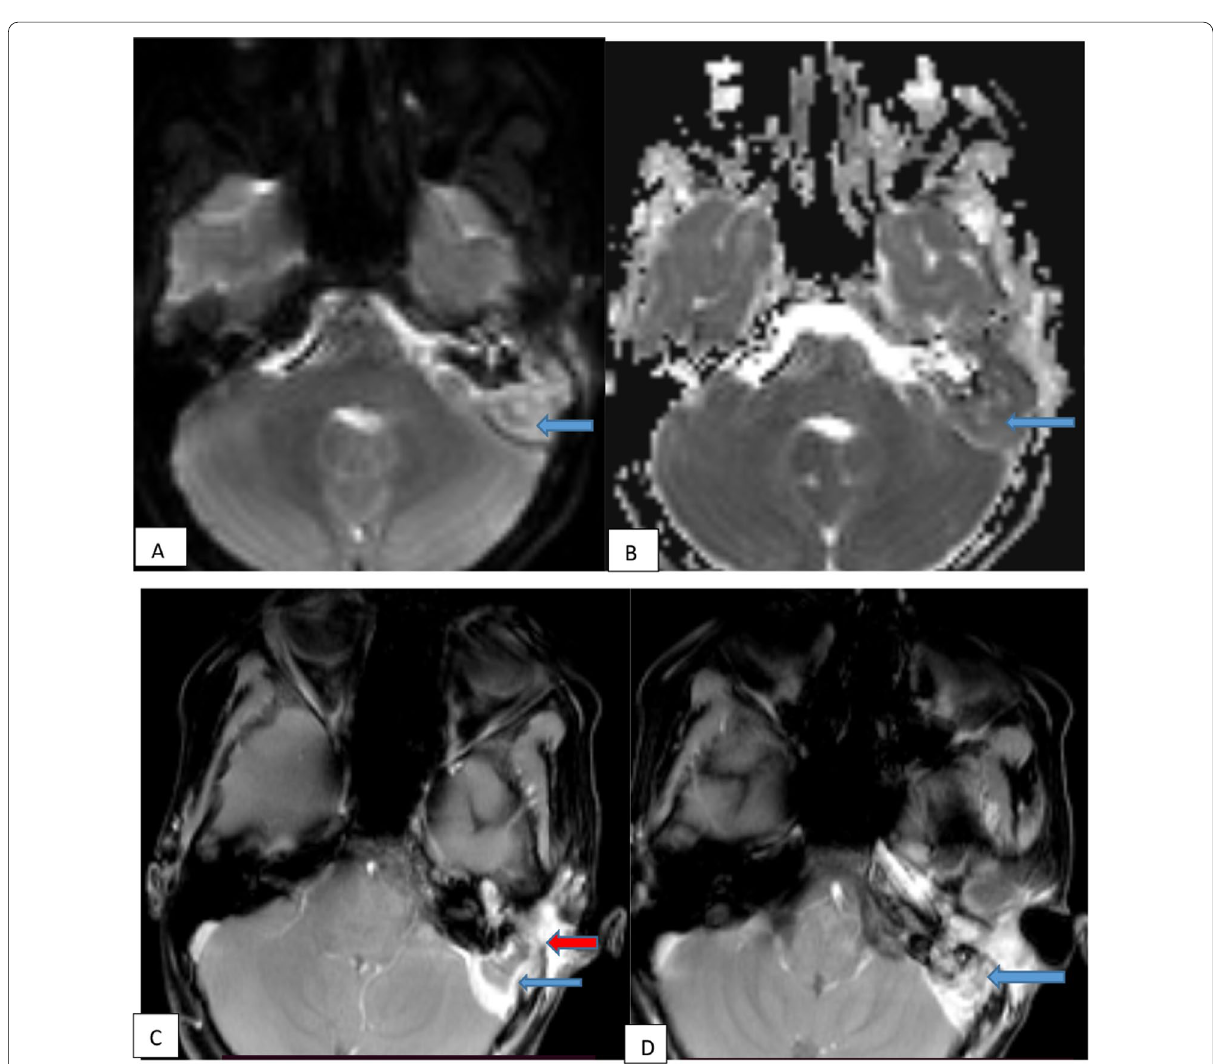
Fig. 3 Axial sections of MR image at base of skull shows: A ) DWI image: restricted diffusion, predominantly in periphery, in the soft tissue along left cerebellopontine angle (blue arrow). B ) ADC image: corresponding signal drop (blue arrow). C ) Post-contrast T1 fat-suppressed MR image: Enhancing soft tissue in left external auditory canal, petromastoid air cells (red arrow) with attenuated calibre of left sigmoid sinus (blue arrow). D ) Post-contrast T1 fat-suppressed MR image: Markedly attenuated calibre with filling defect within distal sigmoid sinus (blue